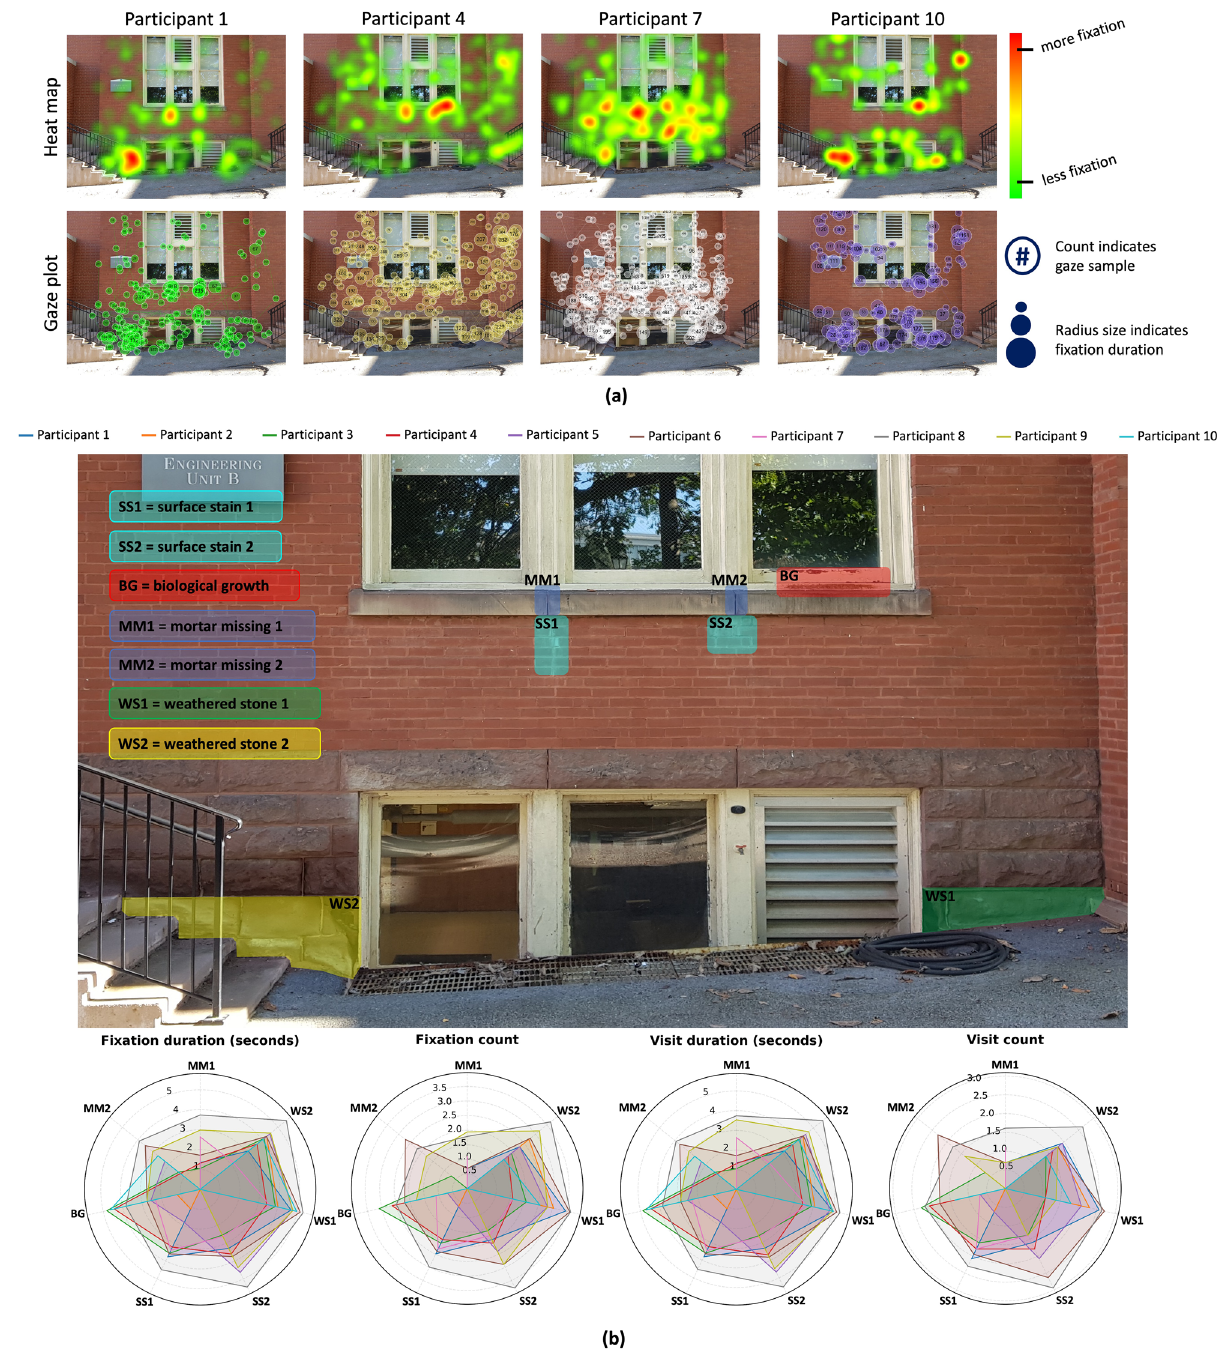
Figure 3. Results of participants data for Building 2 ( a ) Comparison among heat maps and gaze plots of participants ( n = 4 in visual for simplicity; n total = 10), ( b ) Comparison of participant’s eye tracking movements based on damage typology i.e., fixation duration(seconds), fixation count, visit duration (seconds), visit count; legend identify 10 candidates participated in the